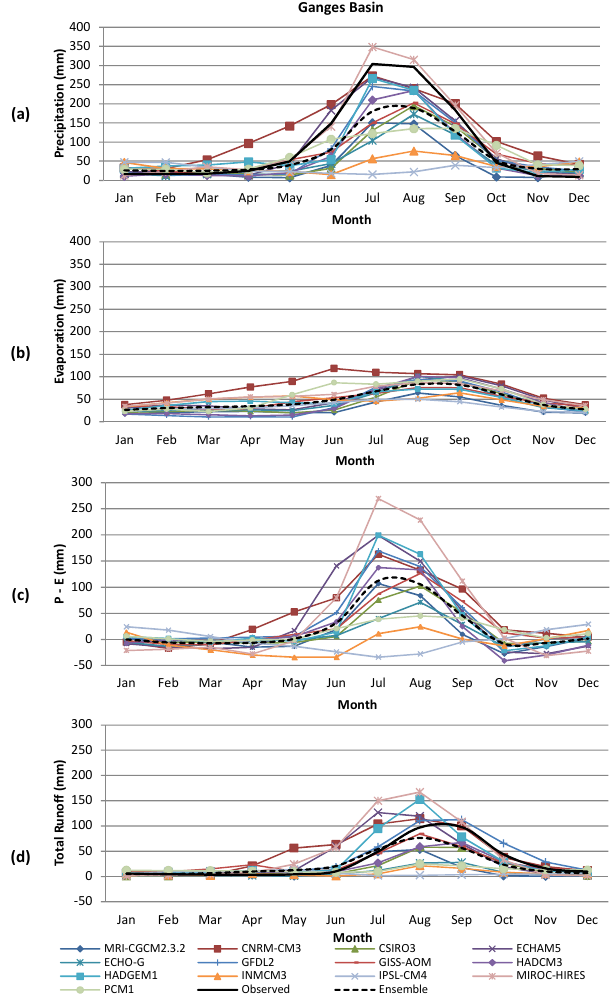
Fig. 3. 20th century annual cycles of considered quantities for the Ganges Basin: (a) P , (b) E , (c) P − E , (d) R